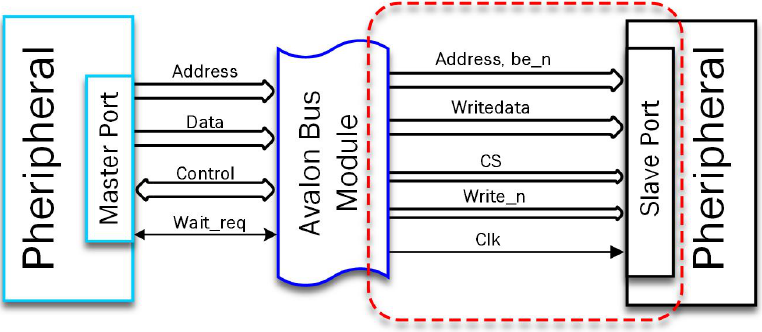
Figure 5. Avalon-based